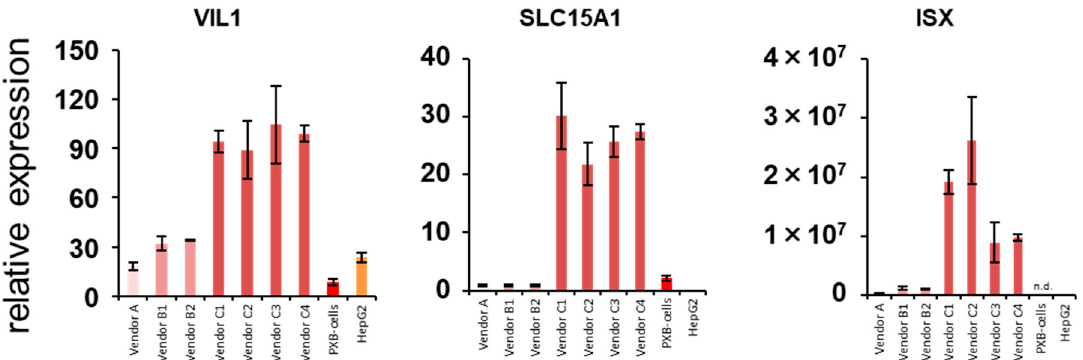
Figure 10. Gene expression levels of intestinal markers in human hepatocytes. The gene expression levels of intestinal markers in cell source candidates for the liver-MPS (hiPSC-Heps, PXB-cells, and HepG2 cells) were measured by qPCR. Pooled RNA from human liver was used for the standard curve, and the expression level was set as one. The relative expression level was calculated using the equation of the line for the standard curve. n = 3. n.d: not detected.